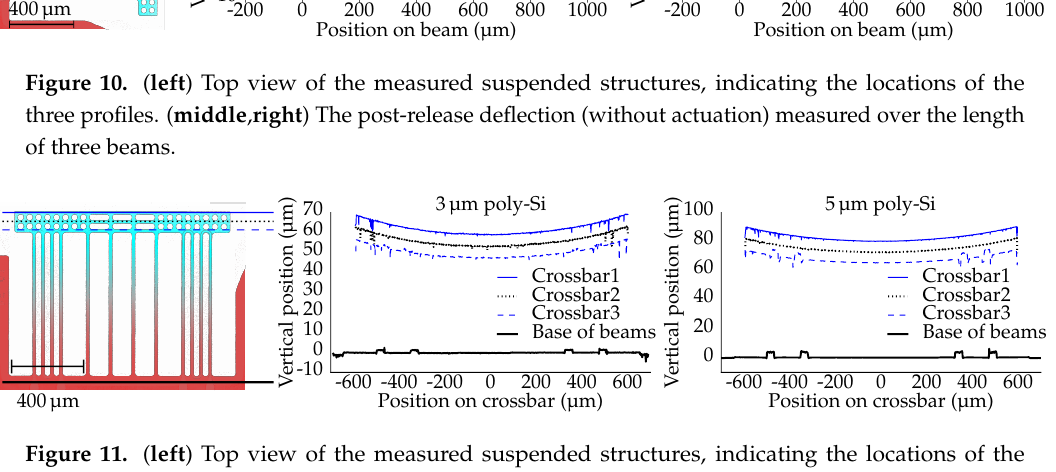
Figure 11. ( left ) Top view of the measured suspended structures, indicating the locations of the four profiles. ( middle , right ) The post-release deflection (without actuation) measured over the length of the crossbar and at the base of the